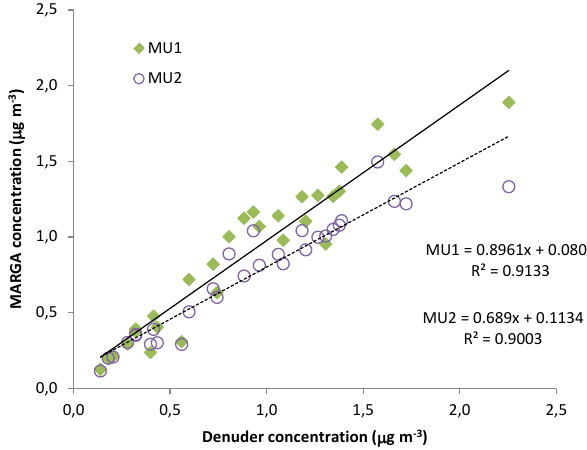
Figure 14. Regression analysis of 24h average MARGA HNO 3 Fig. 14. Regression analysis of 24-hour average MARGA HNO 3 concentrations against denuder 2 concentrations against denuder HNO 3 HNO 3 concentrations. 3